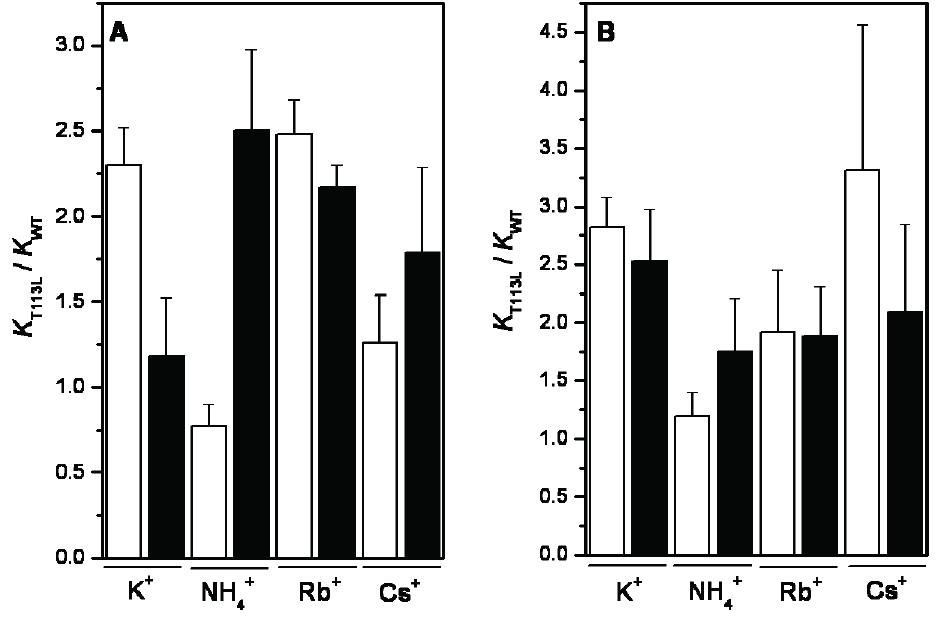
Figure 5. Ratios of K of PEP 3 − for T113L-RMPK and WT-RMPK ( A ) and ratios of ADP-Mg for T113L-RMPK and WT-RMPK ( B ) in 100% of water (white bars) and in 20% DMSO (black bars) activated by the indicated monovalent cations. K of PEP 3 − for both enzymes in 100% water and in 20% DMSO were taken from Tables S1 and S4, respectively; K of the ADP-Mg complex for both enzymes in 100% water and in 20% DMSO was taken from Tables S2 and S5, respectively. K represents K m or K 0.5 . For the experiments carried out in 100% water, NH 4+ was 30 and 60 mM for WT-RMPK and for T113L-RMPK, respectively; the concentration of K + , Rb + and Cs + was 90 mM for both enzymes. For the experiments carried out in 20% DMSO, K + , NH 4+ and Rb + were 15, 9 and 17 mM, respectively, for both enzymes; the concentration of Cs + was 85 and 40 mM for WT-RMPK and T113L-RMPK,